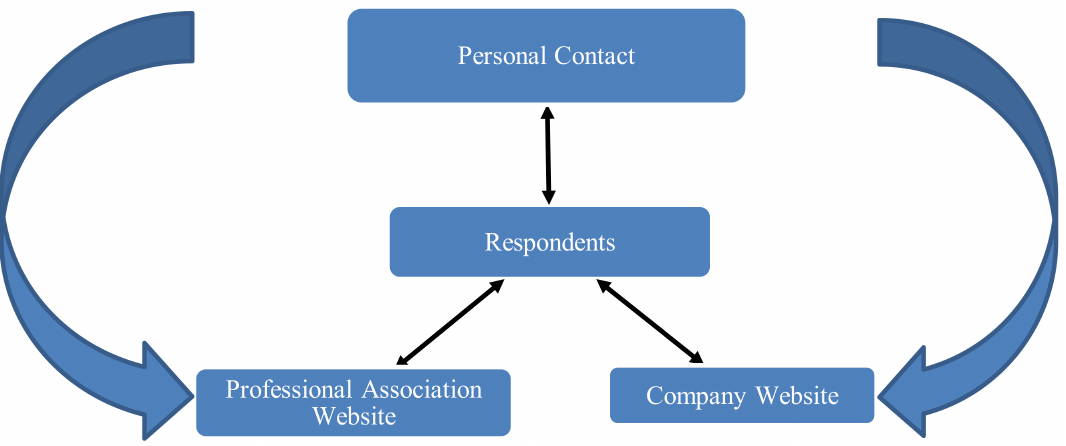
Figure 2. Respondent selection and survey